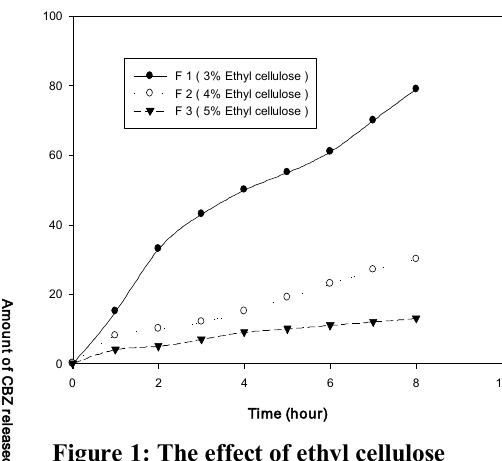
Figure 1: The effect of ethyl cellulose concentration on the release of